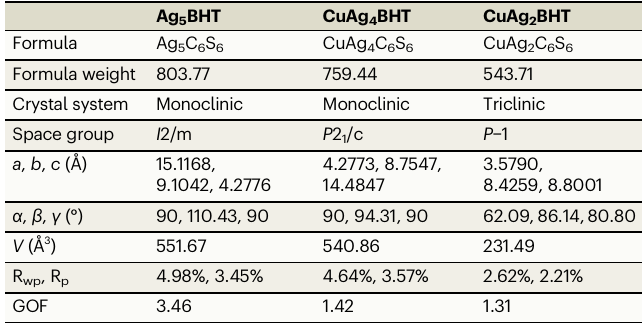
Table 1 | Crystallographic details of Ag 5 BHT (ref. 19) and CuAg x BHT obtained from the Rietveld re fi nement using syn- chrotron PXRD and RED